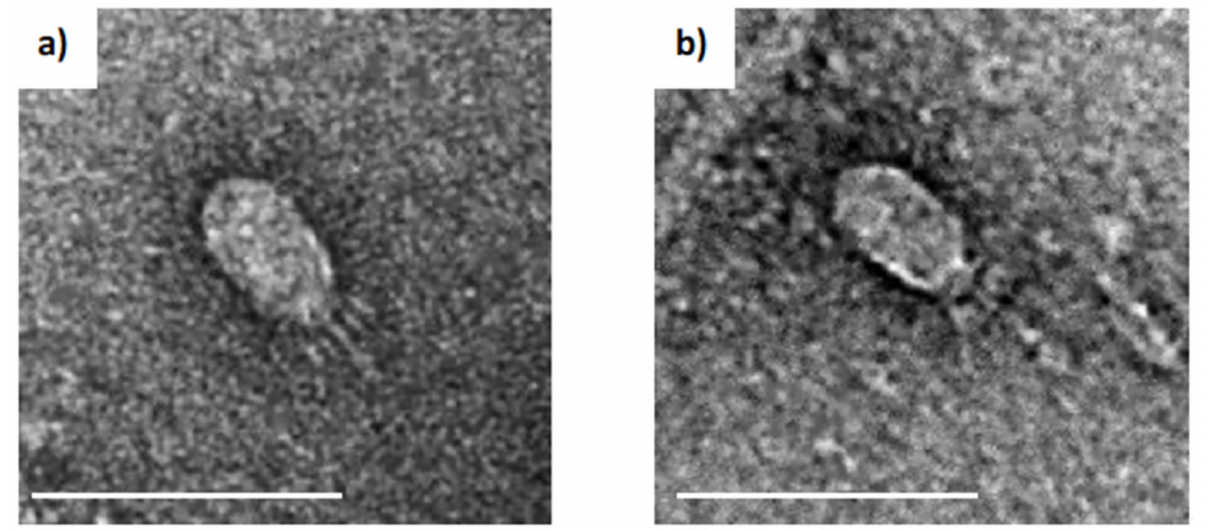
Figure 1. PumA1 and PumA2 morphologies. Transmission electron micrograph of ( a ) PumA1 and ( b ) PumA2. Scale bar = 100